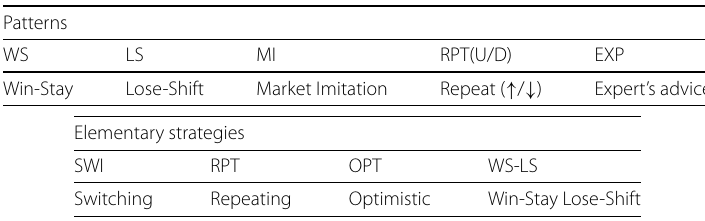
Table 1 Glossary of